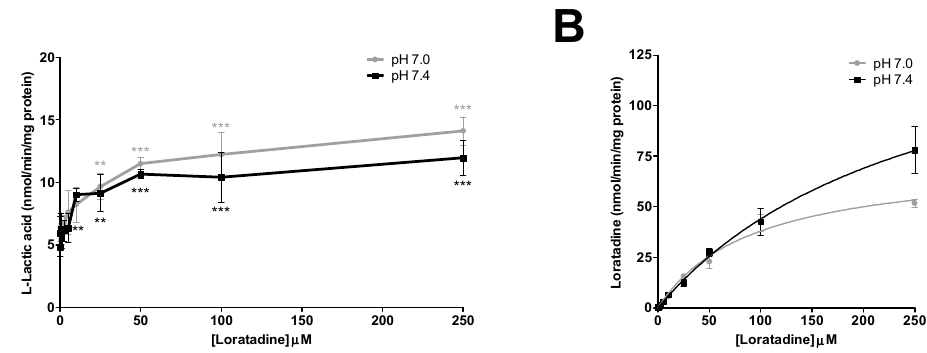
Figure 4. Drug inhibition studies with loratadine in SkMC. ( A ) Inhibitory effects of loratadine on L -lactic acid (6 mM) efflux in SkMC. The residual intracellular [ 14 C] L -lactic acid was measured after 2.5 min of efflux at pH 7.0 and pH 7.4. ( B ) Intracellular concentrations of loratadine at the end of inhibition assays in SkMC at pH 7.0 and pH 7.4. Each point represents the mean ± S.D. of experiments performed in triplicate (* p < 0.05, ** p < 0.01 and *** p < 0.001).